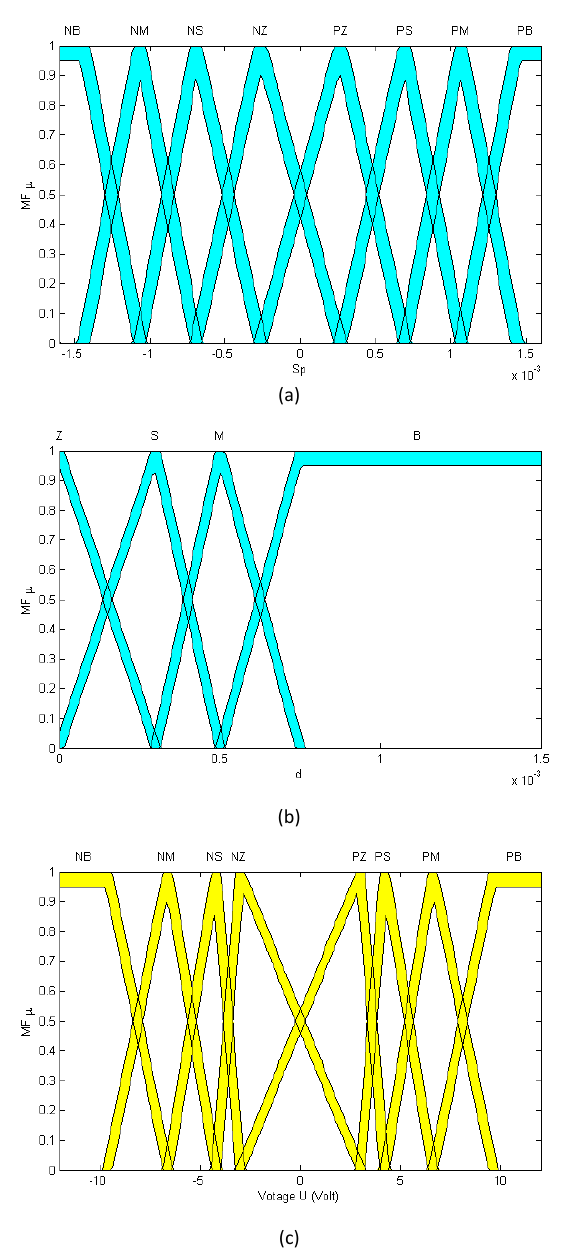
Fig. 1: T2FSMC with firefly algorithm